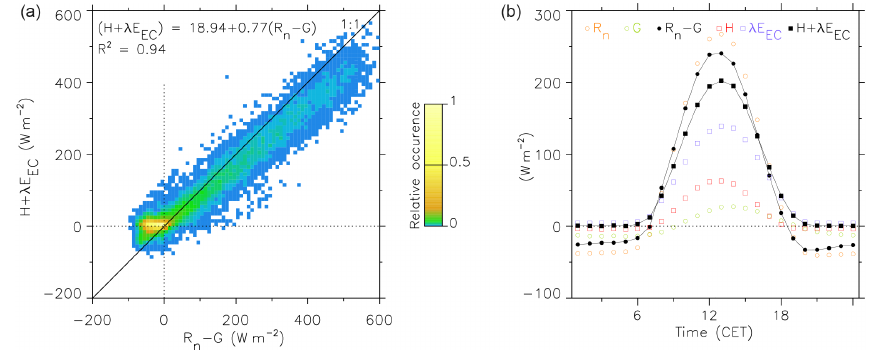
Figure 4. (a) Sum of turbulent fluxes (i.e., sum of sensible heat flux H and latent heat flux λE EC ; H + λE EC ) vs. the available energy (i.e., net radiation R n minus surface soil heat flux G ; R n − G ) and (b) mean daily pattern of the energy balance components. Graphs are based on measured hourly values (i.e., excluding gap-filled data, and masked for precipitation and wind directions affected by the tower) for the time period 1 June 2009–31 December